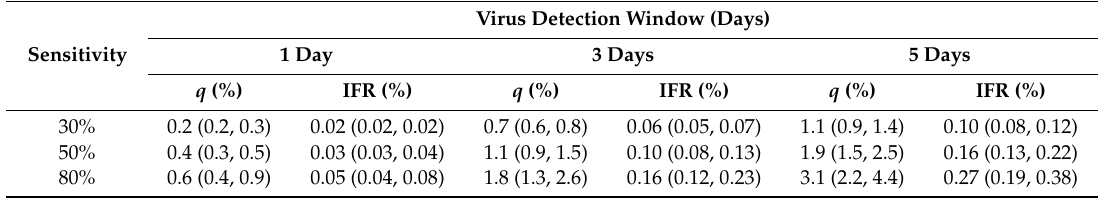
Table 2. Ascertainment rate and infection fatality risk estimates estimated from Japanese evacuees from Wuhan City,